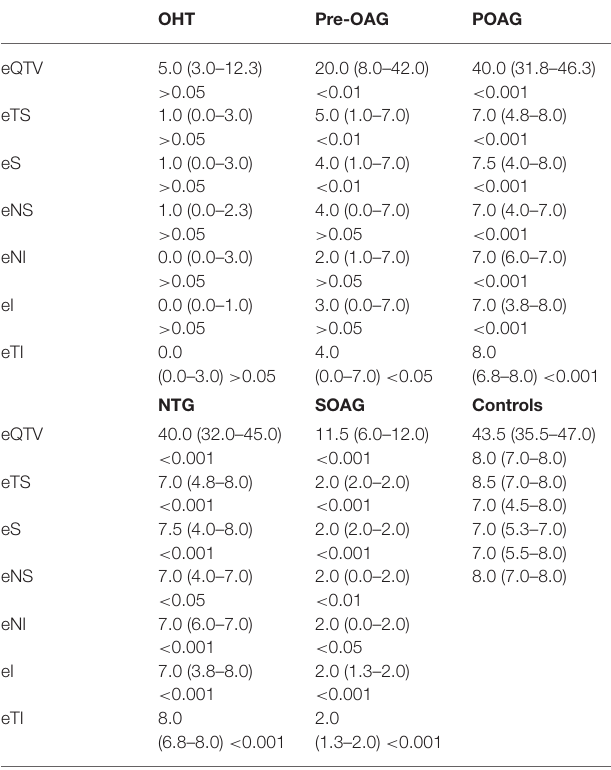
TABLE 7 | Extended QTV (qualitative total value) and extended sector scoring of RGCL thickness (median, quartiles) of all subgroups (OHT, pre-OAG, NTG, POAG, SOAG, controls); eQTV, extended qualitative total value; eTS, extended temporal superior; eS, extended superior; eNS, extended nasal superior; eNI,